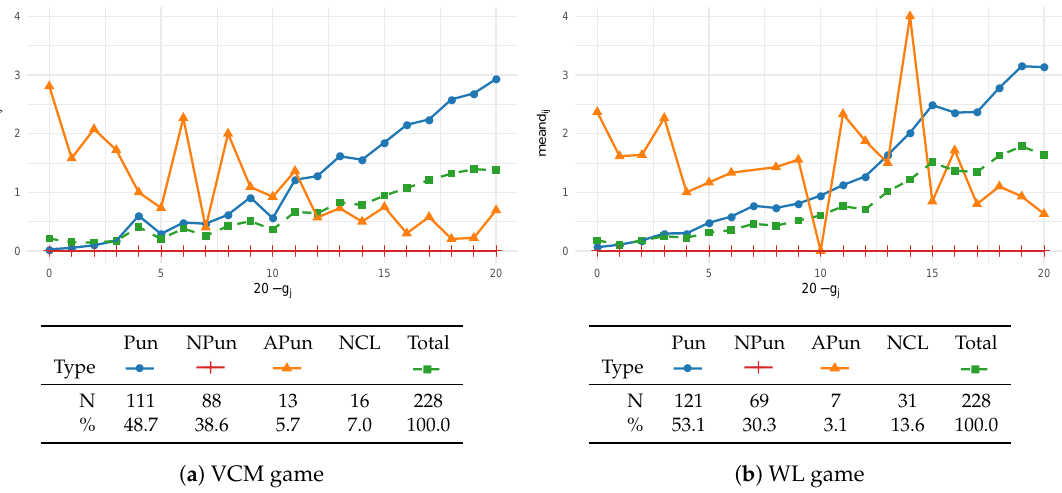
Figure 2. Punishment Types. Notes: Punishment type distribution and mean punishment patterns in the VCM and WL game for different types: pro-social punishers ( Pun ), non-punishers ( NPun ), anti-social punishers ( APun ), and non-classified punishment profiles ( NCL ) (not plotted). Result 1. Within each game setting, there is heterogeneity in individual-level punishment behavior. Across game settings, a majority of subjects shows a consistent inclination for punishment